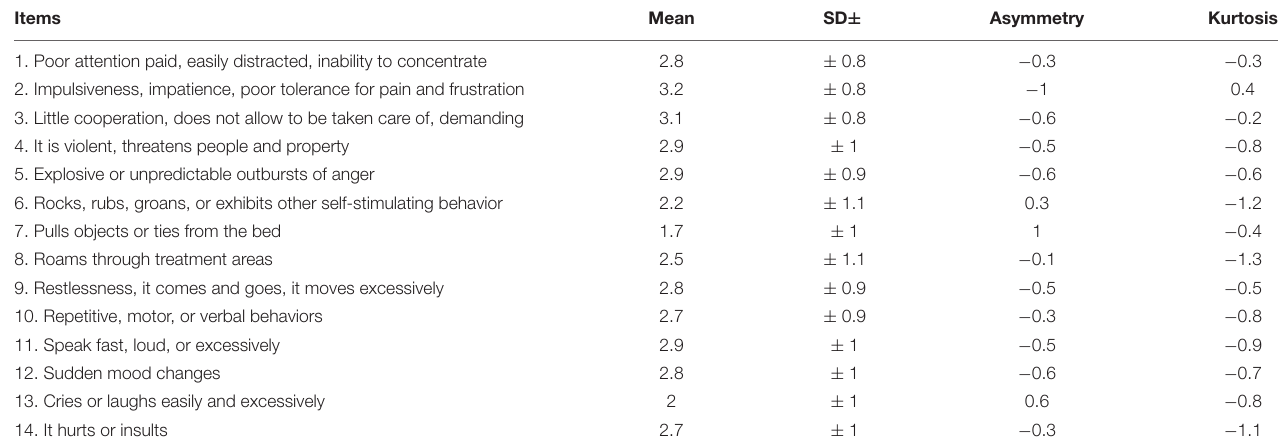
TABLE 2 | Descriptive statistics of the items of the Spanish version of the ABS Corrigan scale.